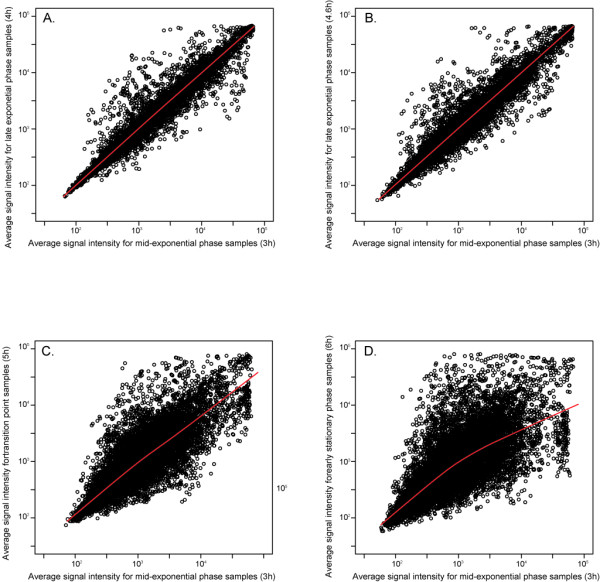
Average signal intensity plots for four of the time points of growth. The normalized signals of 4,886 ORFs for E. coli O157:H7 Sakai were averaged from four hybridizations, representing four biological replicates: A. Average signal intensity for exponential phase (3 h) vs late exponential phase (4 h). B. Average signal intensity for exponential phase (3 h) vs late exponential phase (4.6 h). C. Average signal intensity for exponential phase (3 h) vs transition to stationary phase (5 h). D. Average signal intensity for exponential phase (3 h) vs. stationary phase (6 h. The Lowess line is plotted for each graph in red.